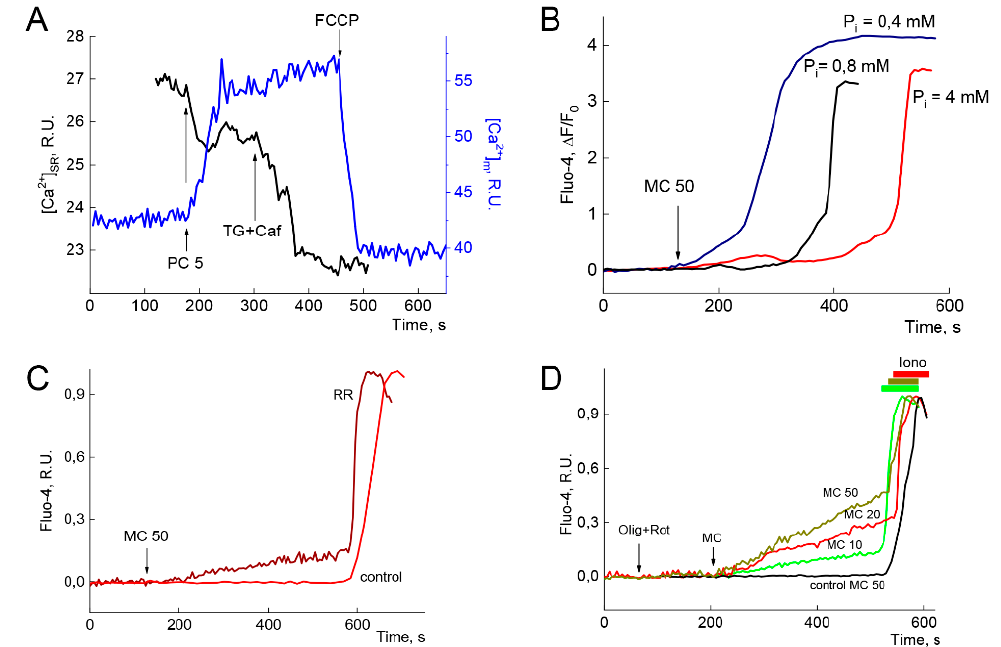
Figure 4. SR-mitochondria interplay. Panel ( A ) depicts redistribution of calcium from SR to mitochondria evoked by PC. At low concentrations, PC (5 µ M) induced decrease in SR Ca 2 + content ([Ca 2 + ] SR , black line) associated with reciprocal rise in mitochondrial [Ca 2 + ] m (blue line) which was measured in another experiment. Two representative Ca 2 + traces are depicted. n = 7, 8. CM were loaded for 30 min with MagFluo-4 or Rhod-2 to monitor the alterations in [Ca 2 + ] SR and [Ca 2 + ] m , respectively. Thapsigargin (100 nM) and ca ff eine (5 µ M) were added to prevent SR Ca 2 + cycling, which resulted in further in [Ca 2 + ] SR lowering indicating correct registration of [Ca 2 + ] SR . Added uncoupler of OXPHOS FCCP (1 µ M) induced rapid loss of mitochondrial [Ca 2 + ] m reflecting the dissipation of ∆Ψ m . Traces presented at the panel are representative of 3 independent experiments. Panel ( B ). E ff ect of inorganic phosphate (P i ) on Ca 2 + bu ff ering in mitochondria and Ca 2 + overload induced by 50 µ M MC. Here, tenfold increase in P i in medium (from 0.4 to 4 mM) resulted in about threefold increment of the lag period, preceding steep rise of [Ca 2 + ] m in cytoplasm, indicating modulation of mitochondrial CRC with P i . Average values of [Ca 2 + ] i (as Fluo-4 ∆ F / F 0 ) are depicted at pane B for all cells ( n = 6, 7, 7). This panel was adapted with permission from [25]. Panel ( C ). E ff ect of ruthenium red (RR, 10 µ M), an inhibitor of Ca 2 + uptake by mitochondria, on Ca 2 + overload induced by 50 µ M MC. This graph shows that moderate inhibition of Ca 2 + uptake via MCU abrogated fine Ca 2 + handling in the cytosol. Cytosolic Ca 2 + slowly increased till the moment of Ca 2 + overload, while the slope and maximum [Ca 2 + ] i were not modified by RR (brown vs. red traces). Average values of [Ca 2 + ] i (as Fluo-4 ∆ F / F 0 ) are depicted in pane C for all cells ( n = 6, 8). This panel was adapted with permission from [25]. Panel ( D ). Inhibition of OXPHOS with oligomycin (1 µ M) and rotenone (1 µ M) prevented Ca 2 + bu ff ering in mitochondria resulting in concentration-dependent Ca 2 + accumulation in cytosol. Concentrations of added MC are indicated on the traces (in µ M). Control experiment (50 µ M MC, black line) was performed in the medium without oligomycin and rotenone. Application of ionomycin (1 µ M, coloured boxes, Iono) was used to normalize Ca 2 + responses in the experiments with oligomycin and rotenone (color lines). Here, representative Ca 2 + traces are depicted. n = 6–10. Traces presented at each panel of Figure 4 depict one of 3 independent